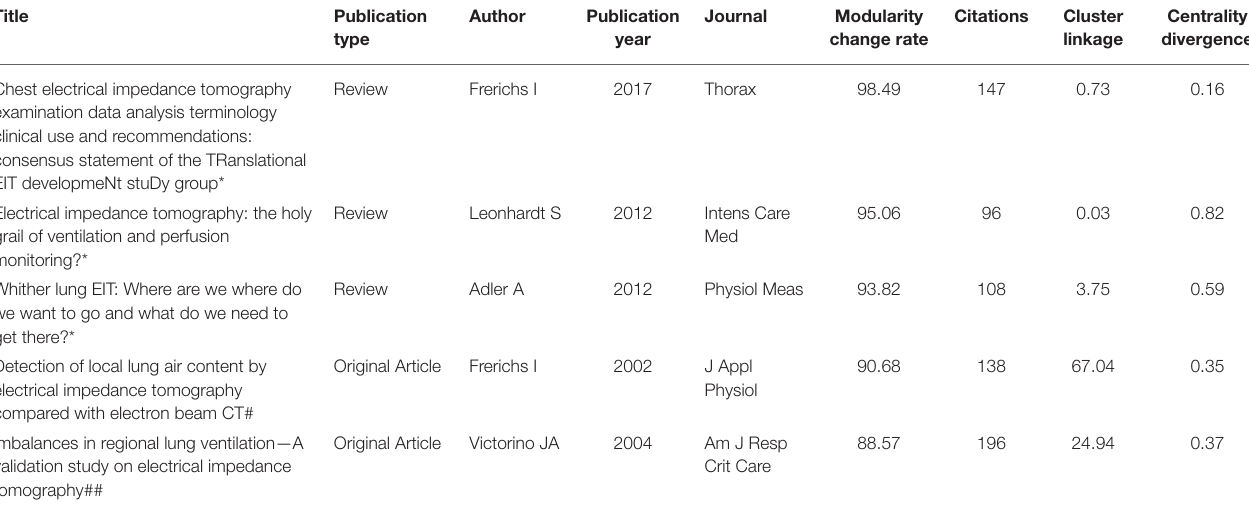
TABLE 4 | The top five co-cited references with the strongest structural variation